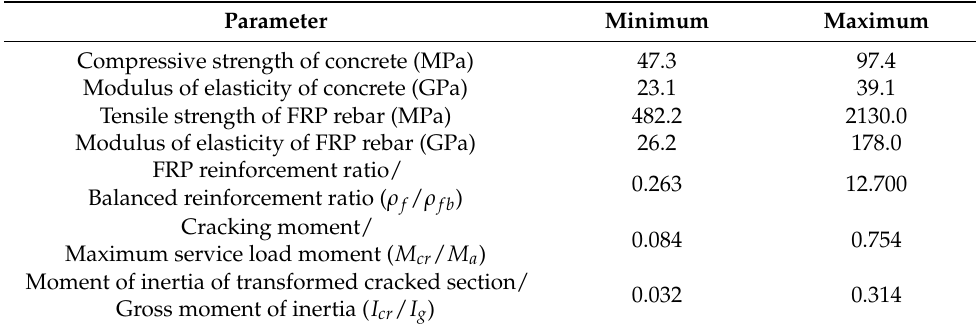
Table 2. Range of parameter changes in experimental data